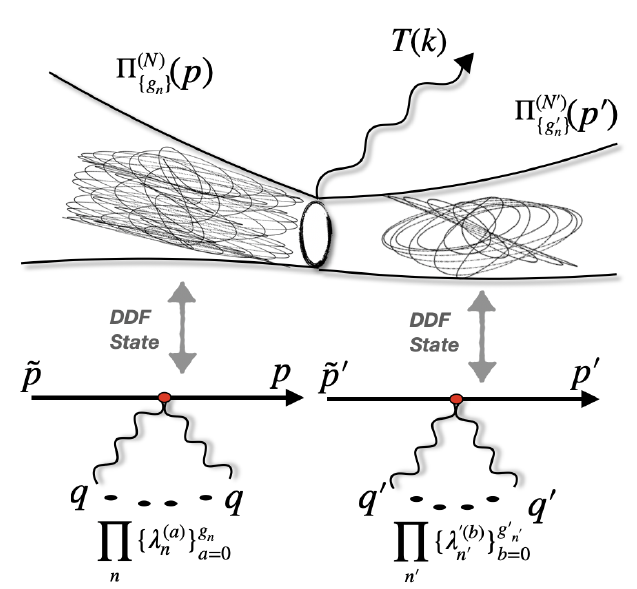
decays into { g n }